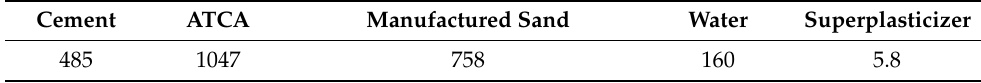
Table 5. Mix ratio of the concrete (unit: kg/m 3 ).